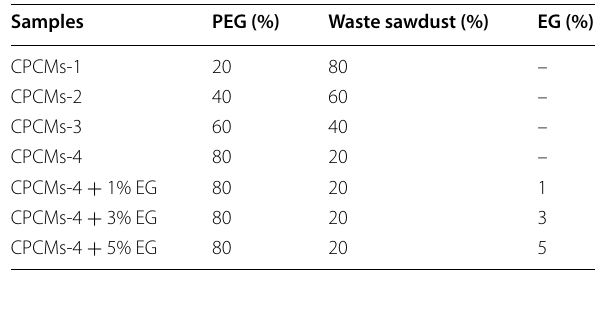
Table 1 The conditions of different composite